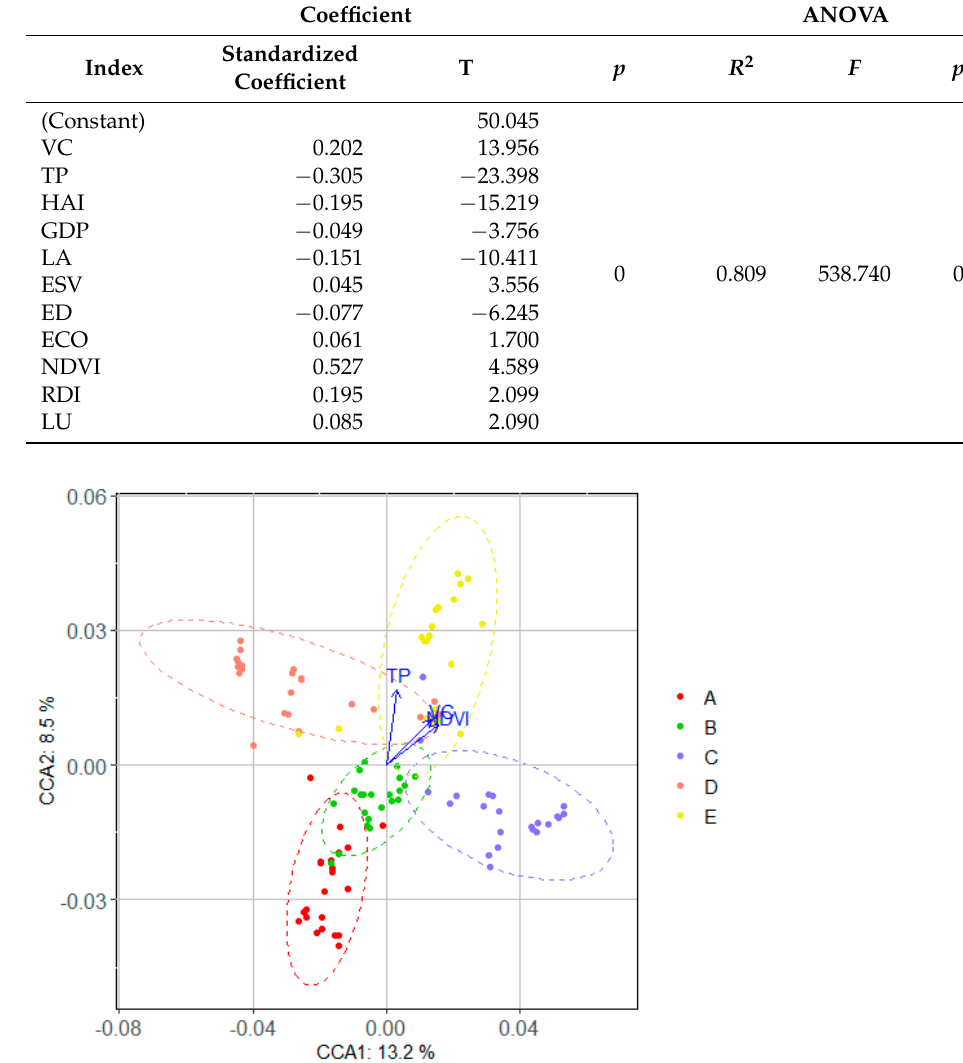
Figure 6. Canonical correspondence analysis of LES in Yan’an from 2000 to 2018. A, B, C, D, E represents the years 2000, 2005, 2010, 2015, and 2018, respectively. NDVI represents normalized differential vegetation index; VC represents vegetation coverage; TP represents land surface temperature.